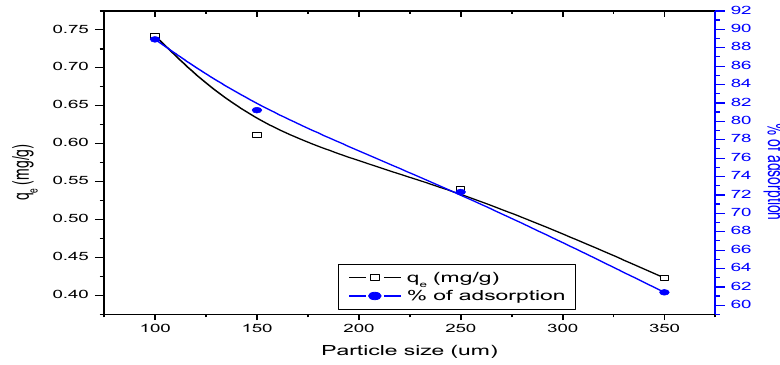
Figure 6b. Effect of particle size on the adsorption of fluoride by eggshell powder (experimental conditions: Initial fluoride concentration: 20.0 mg/L, pH: 6.0, adsorbent dose: 2.4 g/100ml, agitation speed: 250 rpm, Contact time: 60 minutes, Temperature: 303